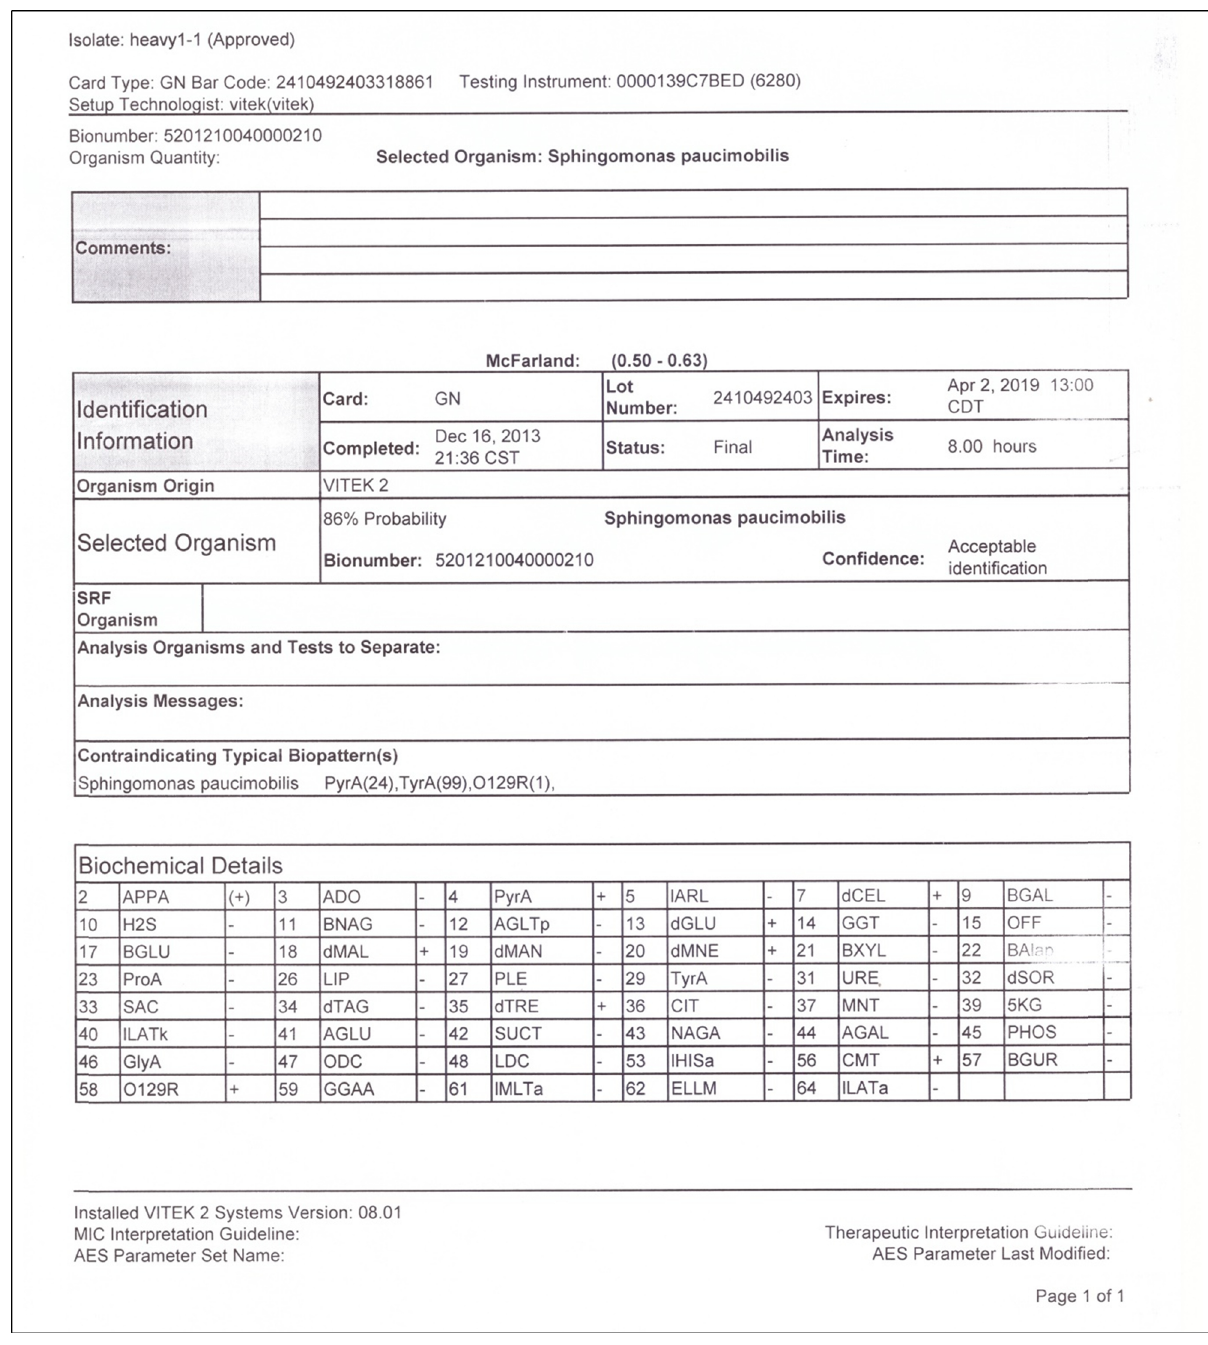
Figure A2: Identi fi cation of microbiota in ileum S. paucimobilis by VITEK 2.